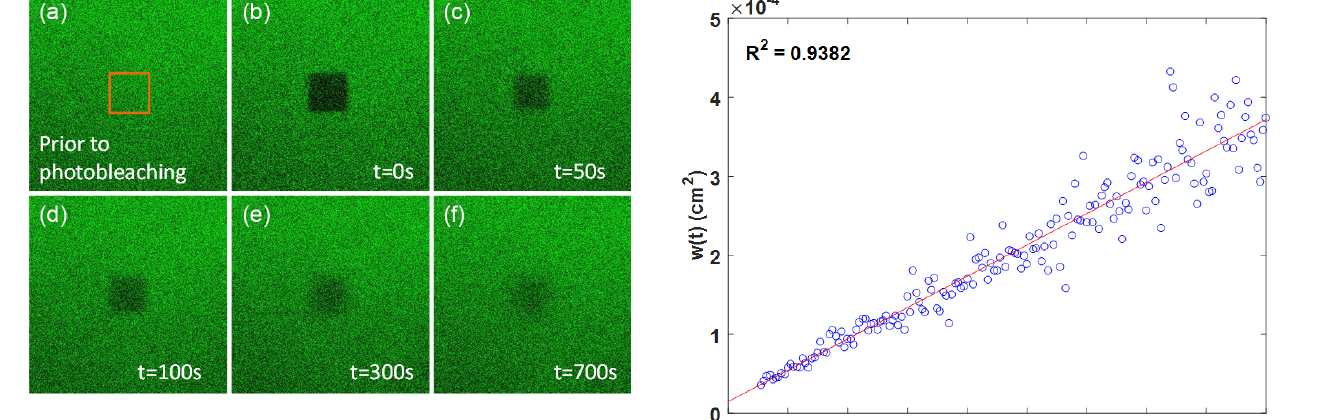
Figure 3. Images recorded during an rFRAP experiment using a thin film composed of 76wt% sucrose solution ( a w = 0 . 75) and trace amounts of rhodamine 6G (0.4mM). The image in (a) was recorded before photobleaching, the image in (b) was recorded im- mediately after photobleaching a 36 × 36µm 2 area and the images in panels (c–f) were recorded at 50, 100, 300 and 700s after pho- tobleaching, respectively. The orange square in (a) represents the 36 × 36µm 2 area selected for photobleaching.